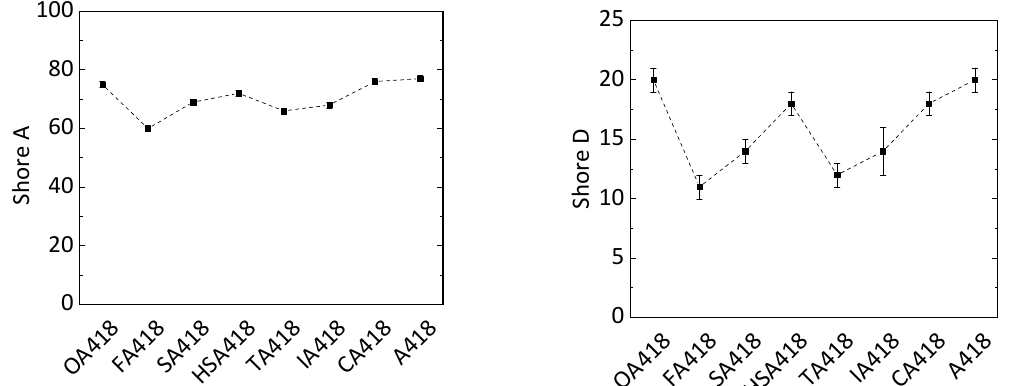
Figure 5. Shore A ( left ) and Shore D ( right ) hardness of epoxy resins with di ff erent biogenic compounds (oxalic acid OA, fumaric acid FA, succinic acid SA, malic acid HSA, tartaric acid TA, itaconic acid IA and citric acid CA) in the hardener system (MA, MTHPA and X; X = biogenic compound).